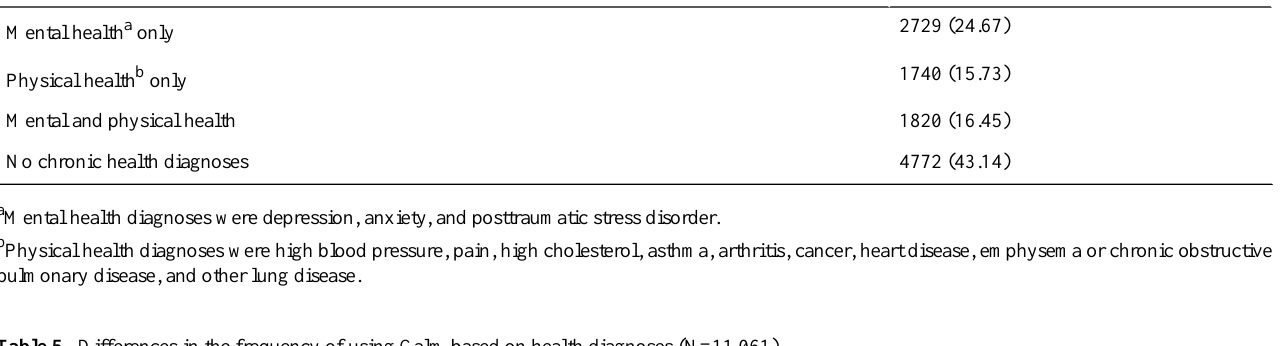
Table 5. Differences in the frequency of using Calm based on health diagnoses